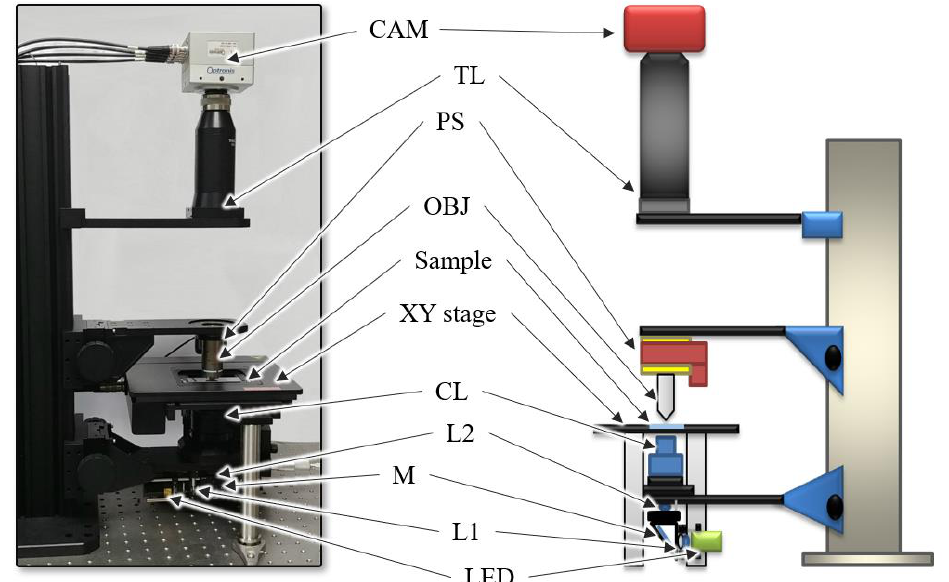
Figure 1. Schematics of the experimental setup. Light-emitting diode (LED): light source, L: lens, M: mirror, CL: condenser lens, OBJ: objective lens, PS: piezo stage, TL: tube lens and CAM: camera.